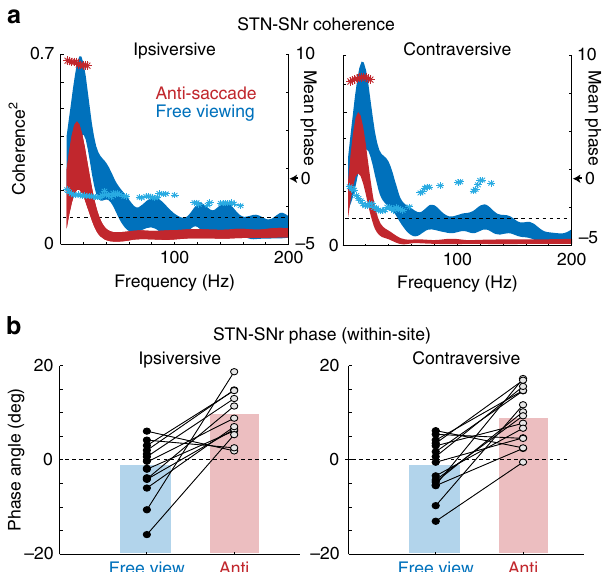
Fig. 2 STN-SNr coherence and phase angle during the 200 msec period before free viewing saccade (blue) and anti-saccade (red) onset. No visual stimuli were present at the fi xation point or saccade target during this period in either task (i.e., unconstrained and free reward during free viewing; goal directed and reward driven during anti-saccades. a STN-SNr coherence across frequencies, line width re fl ects population standard error, and horizontal dashed lines re fl ect the 99% con fi dence line against 0. STN and SNr LFP was coherent from 5 to 29 Hz before anti-saccade onset, and from 5 to 48 Hz before free viewing saccade onset. STN-SNr coherence was signi fi cantly higher during the free viewing saccade task than anti- saccade task, from 31 to 58 Hz (Wilcoxon Rank-Sum Test, p < 0.05). Asterisks indicate STN-SNr LFP phase angle at frequencies when STN-SNr coherence is above 99% con fi dence. b STN-SNr LFP phase angle is compared within sites, in the 15 – 25 Hz frequency window encompassing peak coherence. There was a negative phase angle between STN and SNr signals during free viewing, but a positive phase angle during anti-saccades, consistent with a weighting shift in subthalamo-pallidal